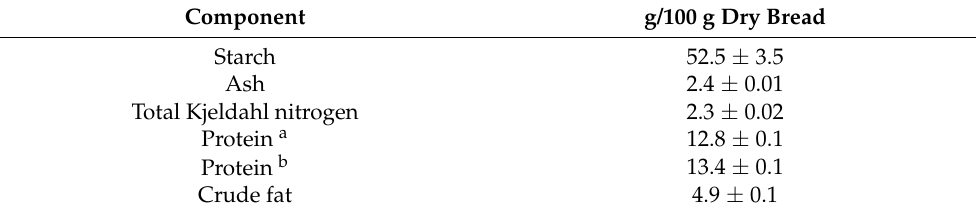
Table 2. Composition of the